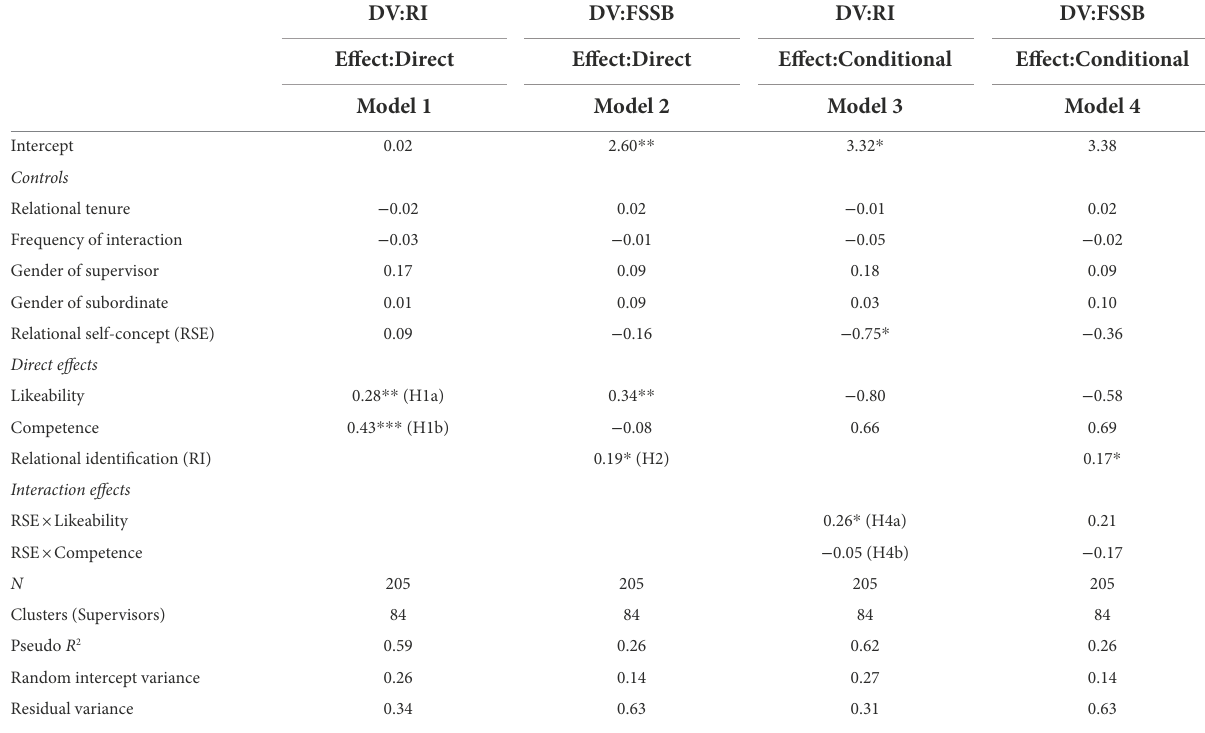
TABLE 1 Mixed-effects analysis with random-intercept.